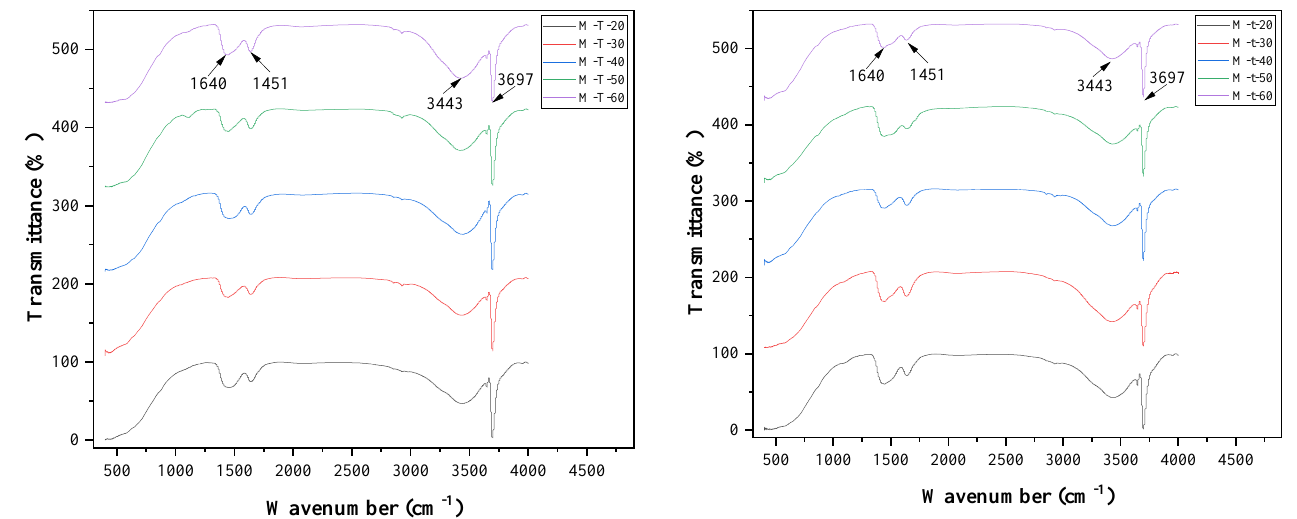
Figure 1. The ( a ) XRD pattern and ( b ) ATR-FTIR spectra of the synthetic nano-Mg(OH) 2 . Table 3. The XRD parameters and grain size of the synthetic nano-Mg(OH) 2 .